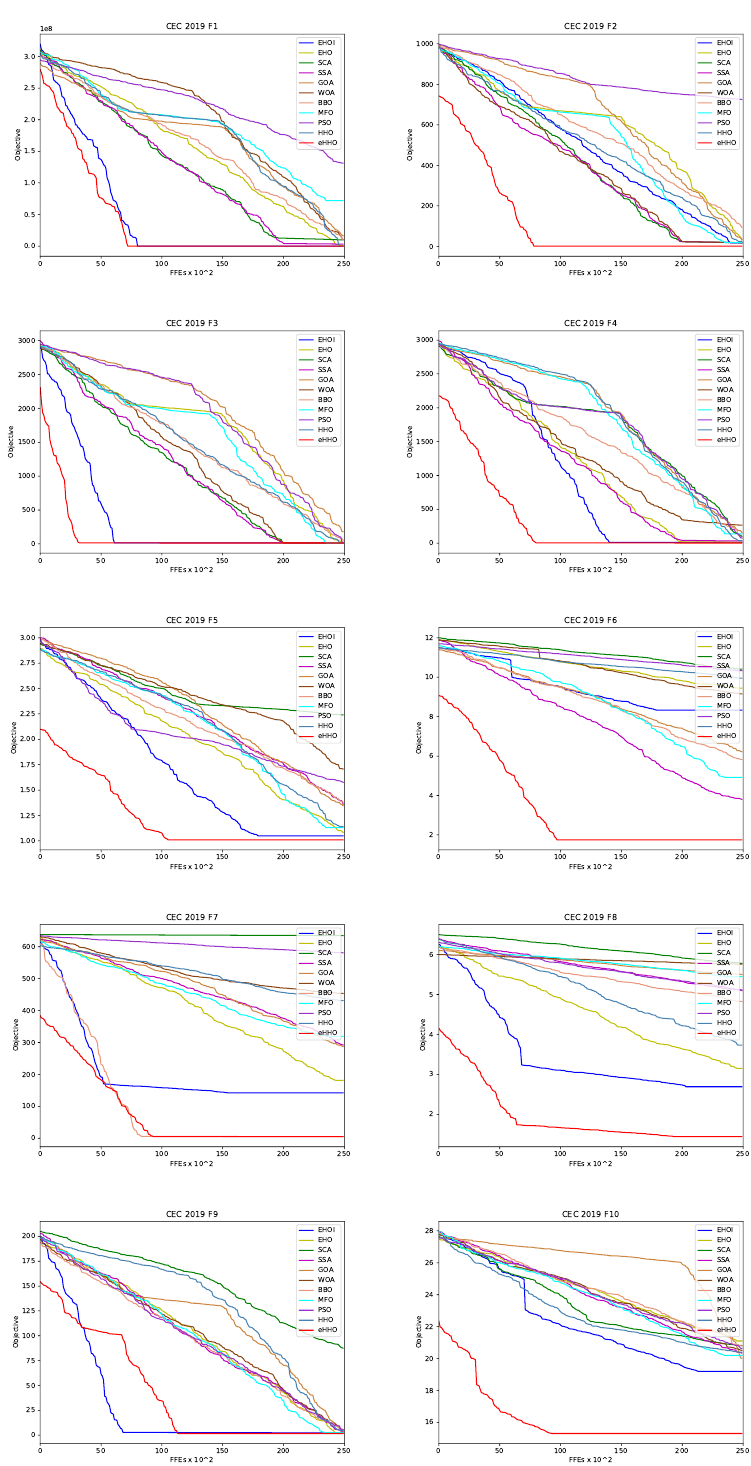
Figure 1. Graphs for convergence speed comparison for 10 CEC2019 benchmark functions—eHHO vs. other